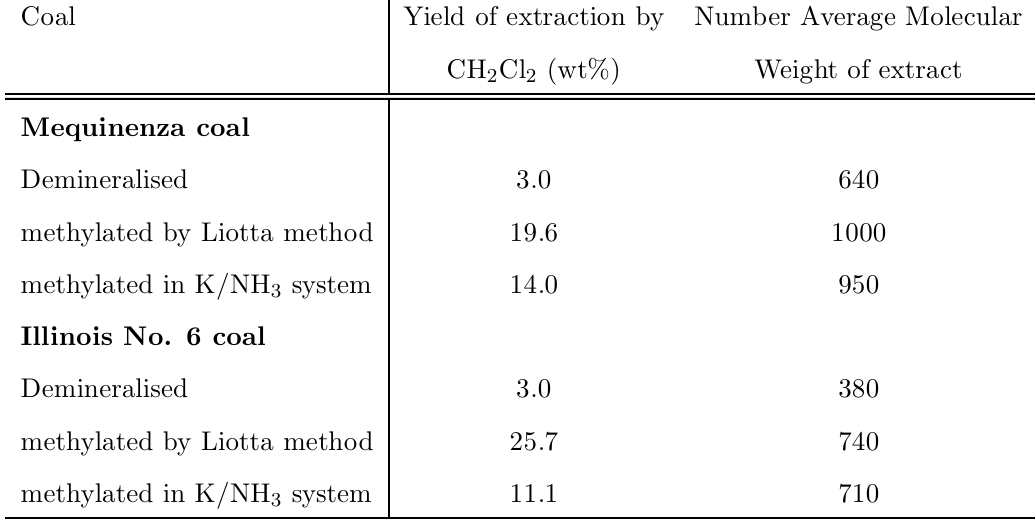
Table 1 Characteristics of CH 2 Cl 2